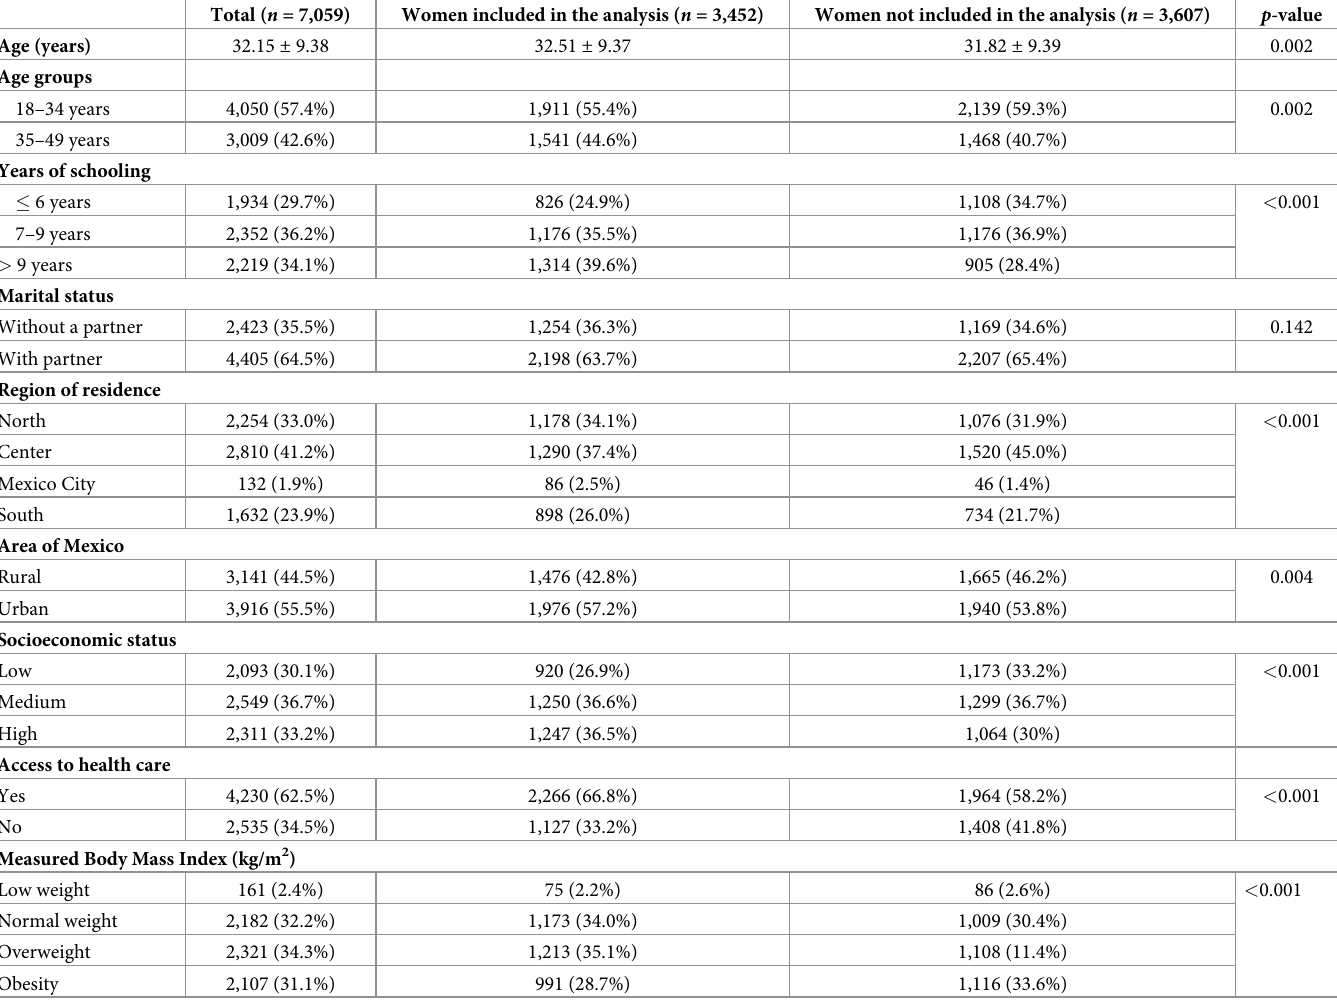
Table 1. Demographic characteristics between women included and women not included in the analysis. Total ( n = 7,059) Women included in the analysis ( n = 3,452) Women not included in the analysis ( n = 3,607) p